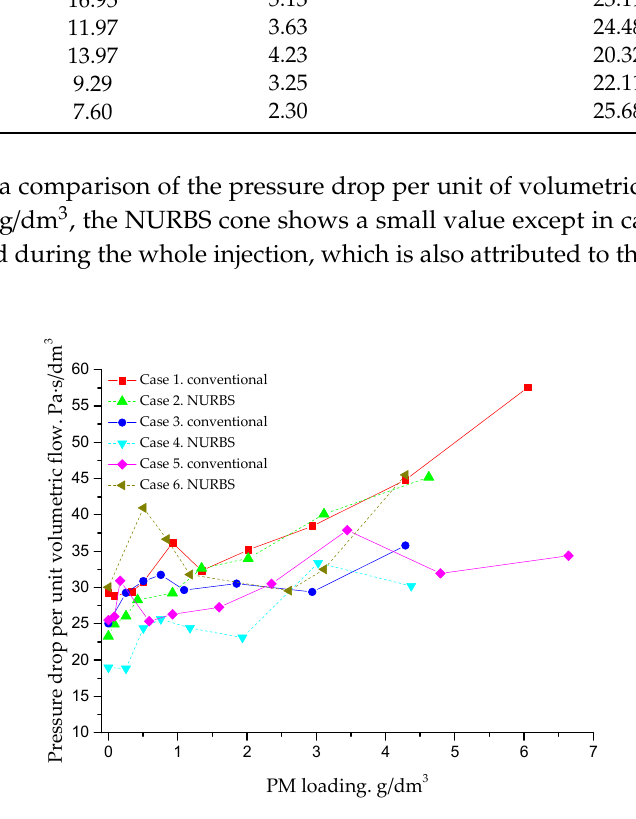
Figure 9. Comparison of the pressure drop per unit volumetric flow.